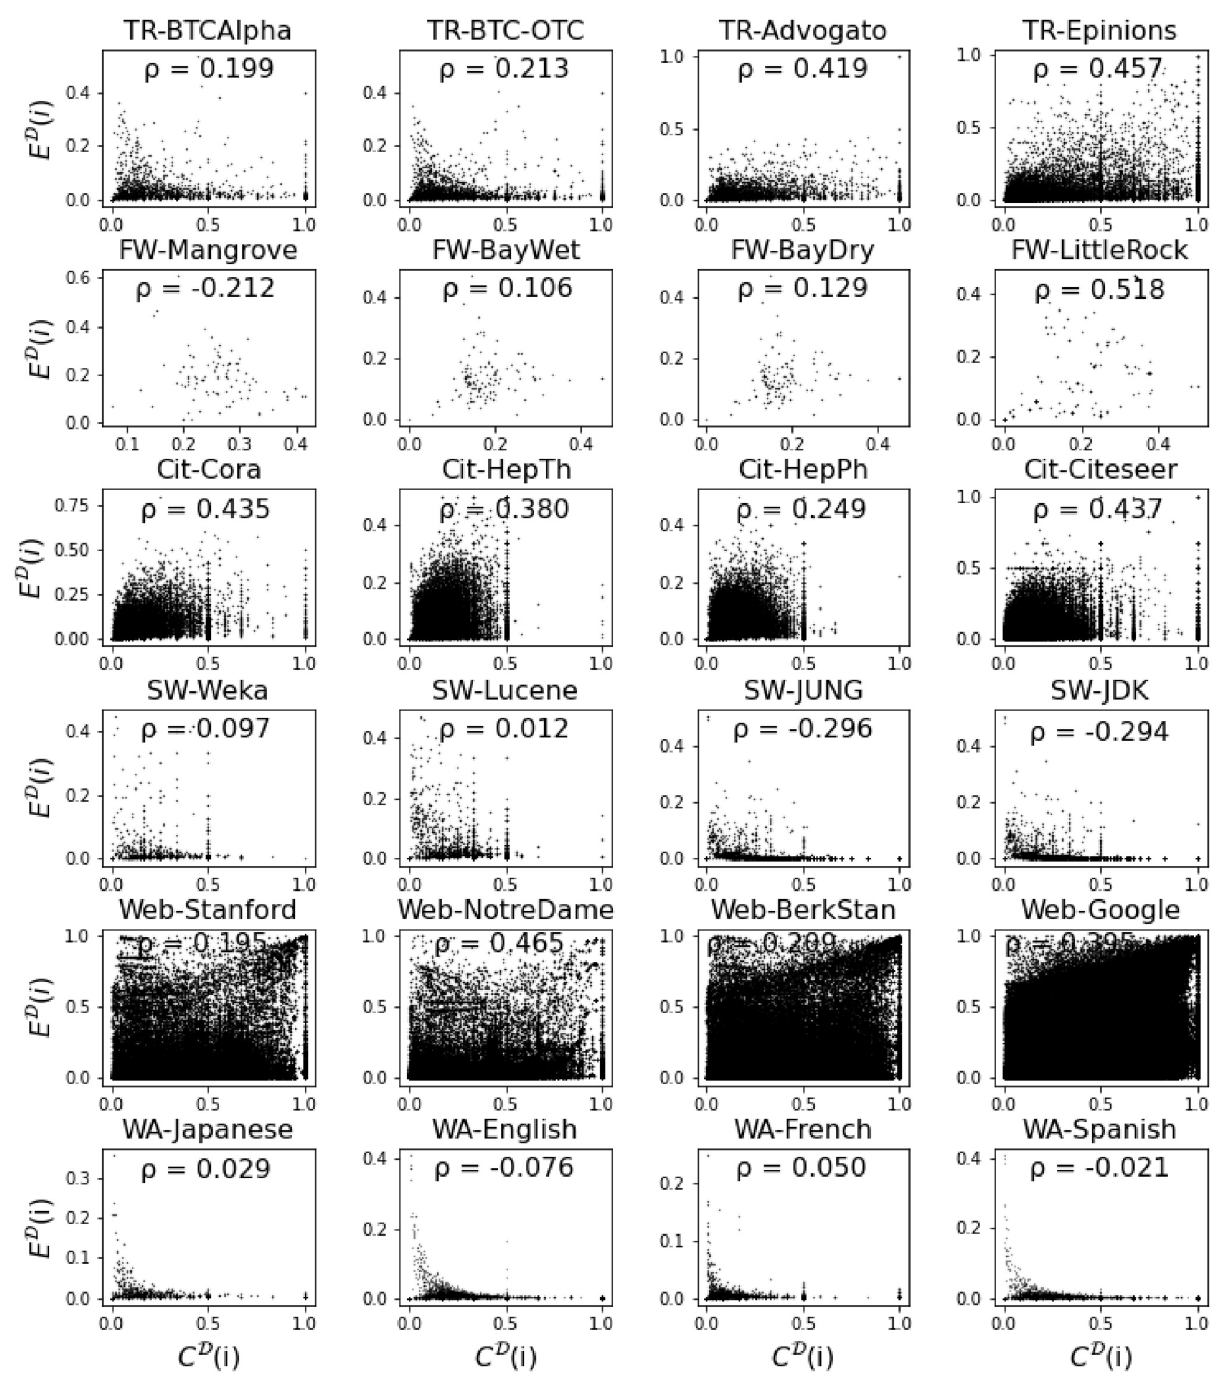
Fig 7. Correlation between the directed clustering coefficient and the directed closure coefficient, together with the Pearson correlation coefficient ρ . Each dot in the plot represents a node in the network.